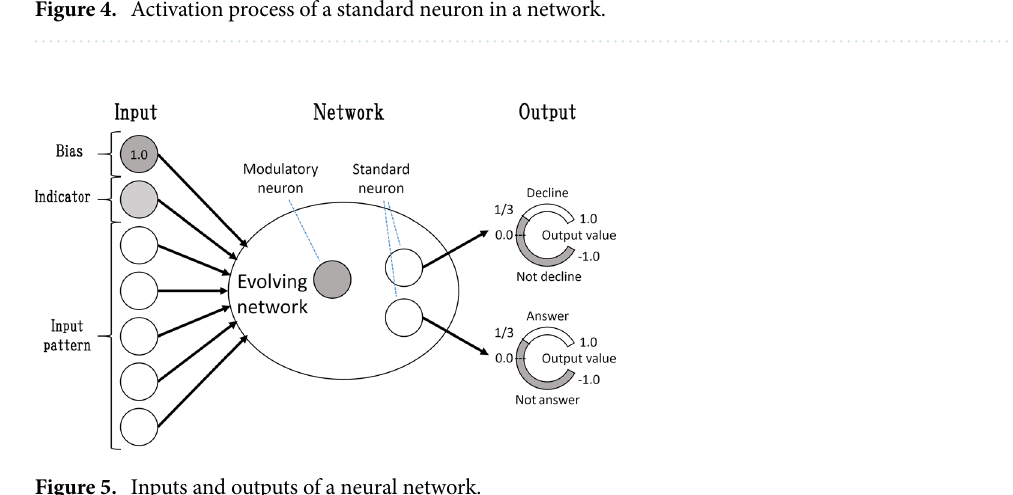
Figure 4. Activation process of a standard neuron in a network.